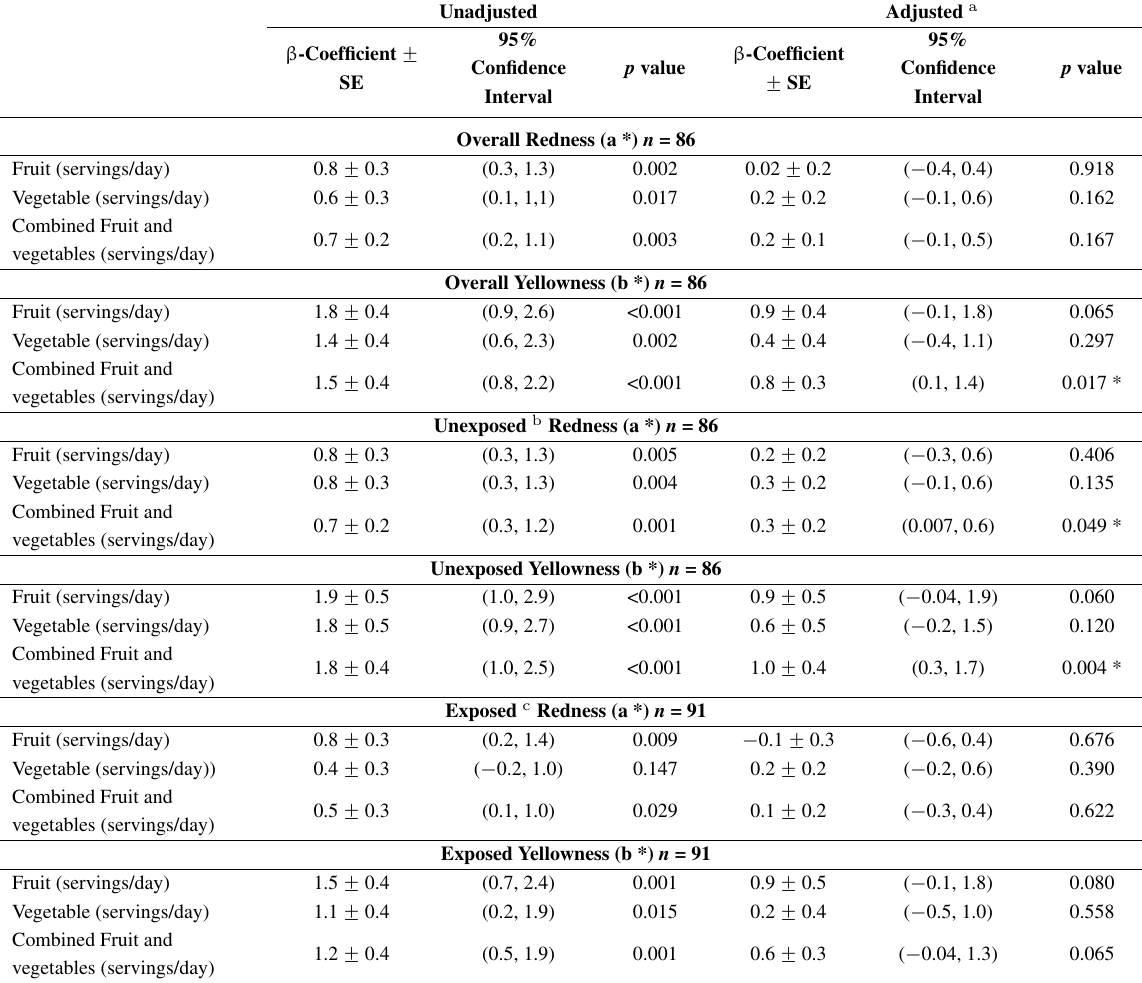
Table 2. Multiple regression analyses between fruit and vegetable intake and skin color (CIE